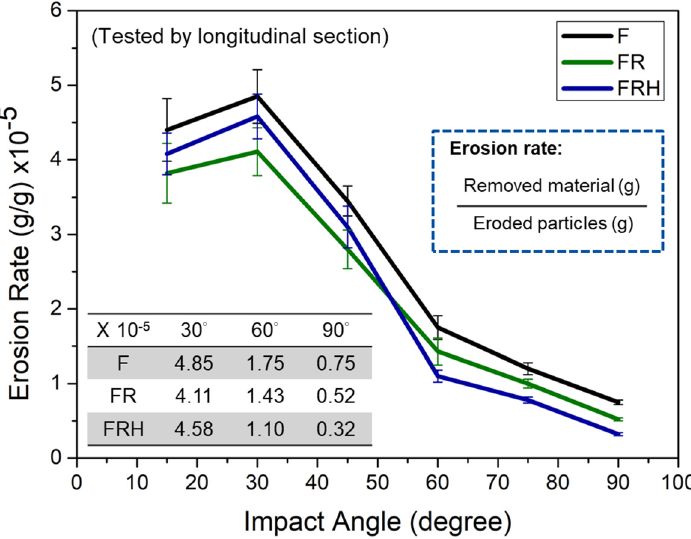
Figure 6. Erosion rate as a function of the impact angle of the CCDR Al–Si alloy.